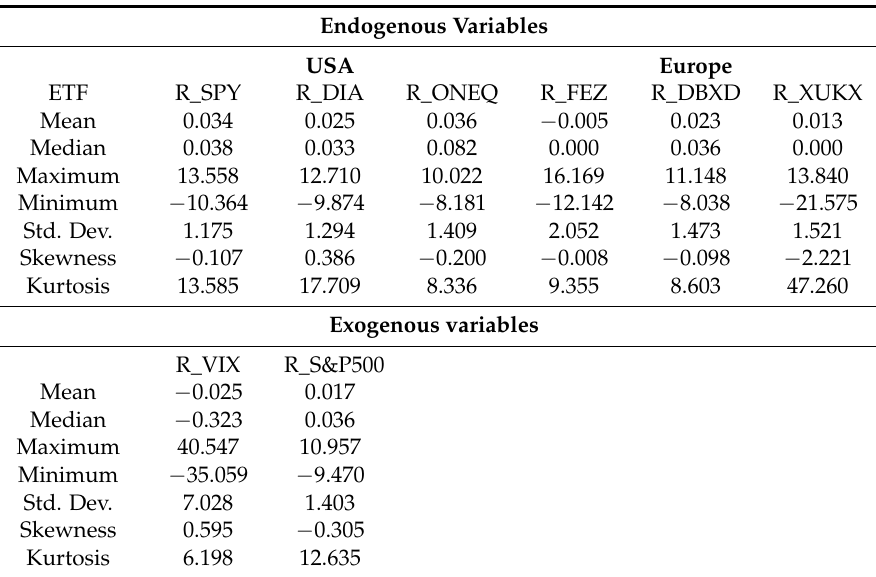
Table 2. Sample Statistics.